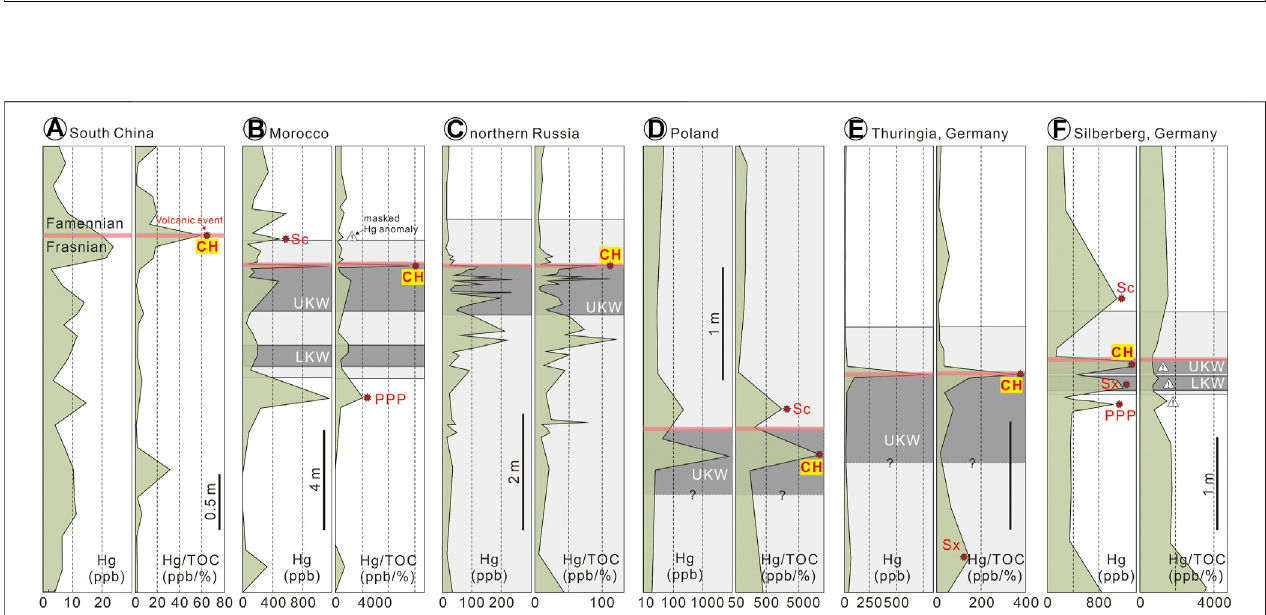
FIGURE5| F – Fsections in (A) SouthChina, (B) Morocco, (C) northRussia, (D) Poland, (E) Thuringia,Germany,and (F) Silberberg,Germany(modi fi edafterRacki et al., 2018; Racki, 2020) showing Hg enrichments with highlights on their probable correlation with bentonite beds by Winter (2015). Abbreviation: CH, Center Hill; Sc, Scorpius; Sx, Sextans, PPP, Pictor – Phoenix – Pegasus.